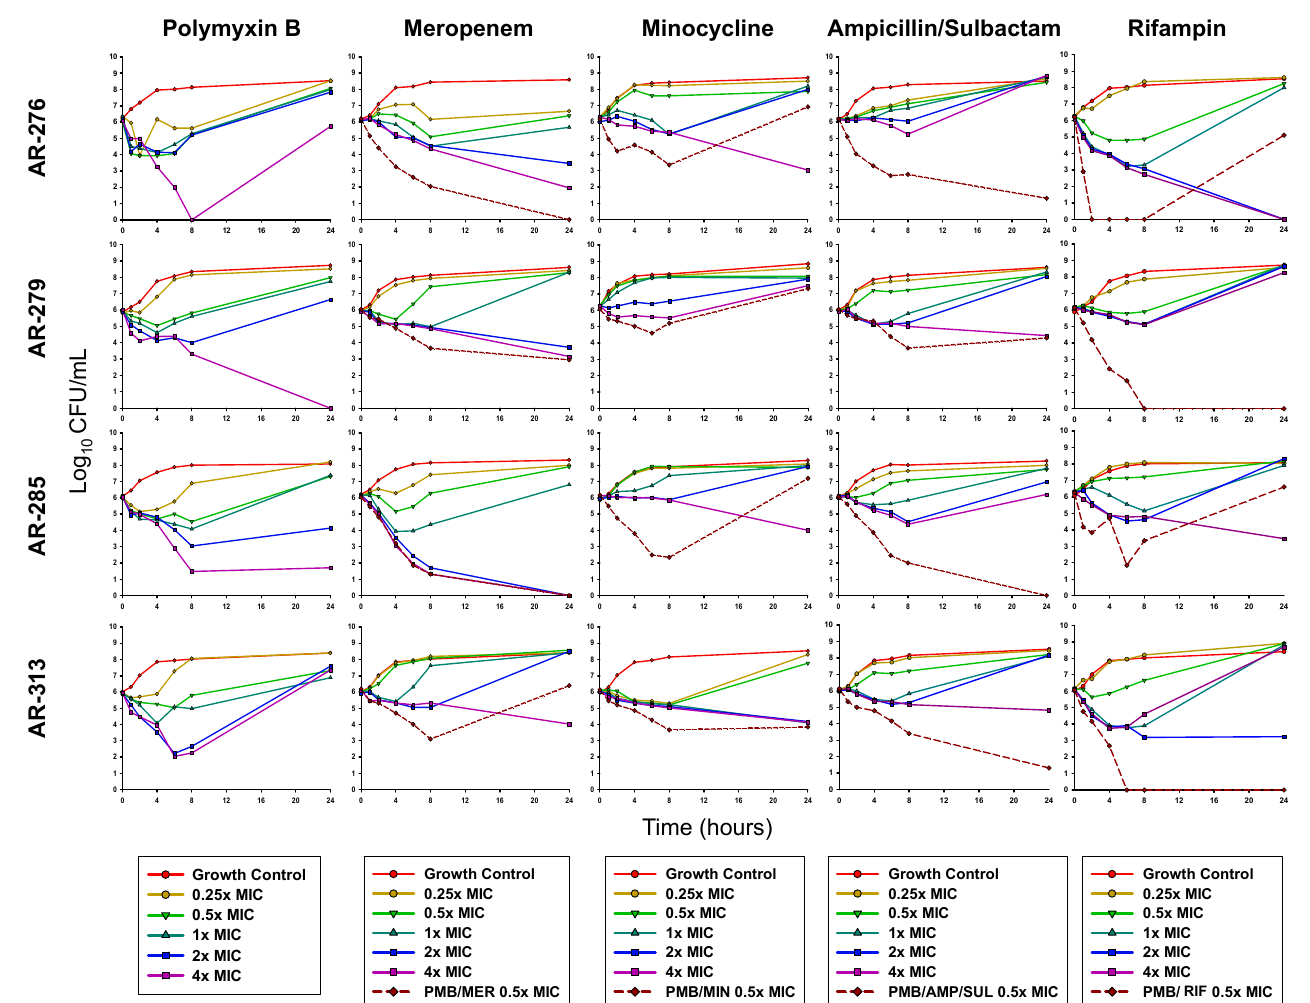
Figure 1. Mean viable bacterial counts of planktonic CRAB in static time ‐ kill experiments. For combinations, each antibiotic was tested at a concentration of 0.5 × MIC. PMB, polymyxin B; MER, meropenem; MIN, minocycline; AMP/SUL, ampicillin/sulbactam; RIF, rifampin. The combination of PMB and MER was bactericidal and synergistic against AR ‐ 276, AR ‐ 279, and AR ‐ 285, with a mean reduction of 5.11 log 10 CFU/mL. In contrast, no bacterial killing was noted for PMB/MER against AR ‐ 313. PMB/MIN only displayed synergy against isolate AR ‐ 313 (2.28 log 10 CFU/mL reduction) while the other isolates grew above the starting inoculum by 24 h in the presence of this combination. The combination of PMB and AMP/SUL was bactericidal against isolates AR ‐ 276, AR ‐ 285, and AR ‐ 313 at 24 h and synergy was observed against all four isolates. PMB and RIF were bactericidal and synergistic against AR ‐ 279 and AR ‐ 313. AR ‐ 285 regrew between 8 and 24 h in the presence of this combination.